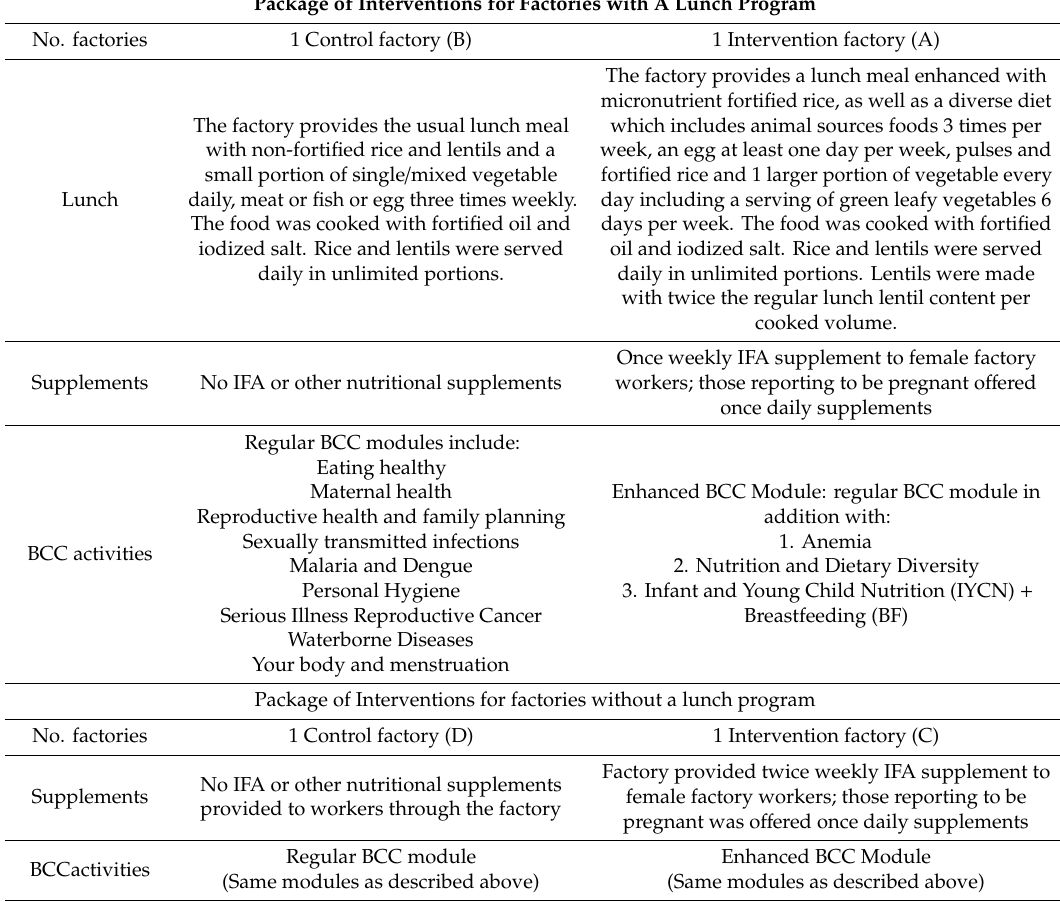
Table 1. Summary of the package of interventions in the intervention and control factories with and without a lunch